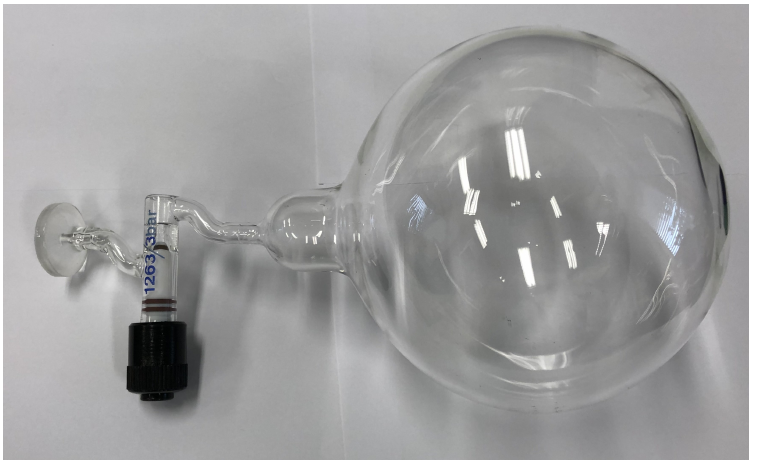
Figure 4. Glass ball, manufactured at FZ Jülich, for the storage of polarized 3 He.